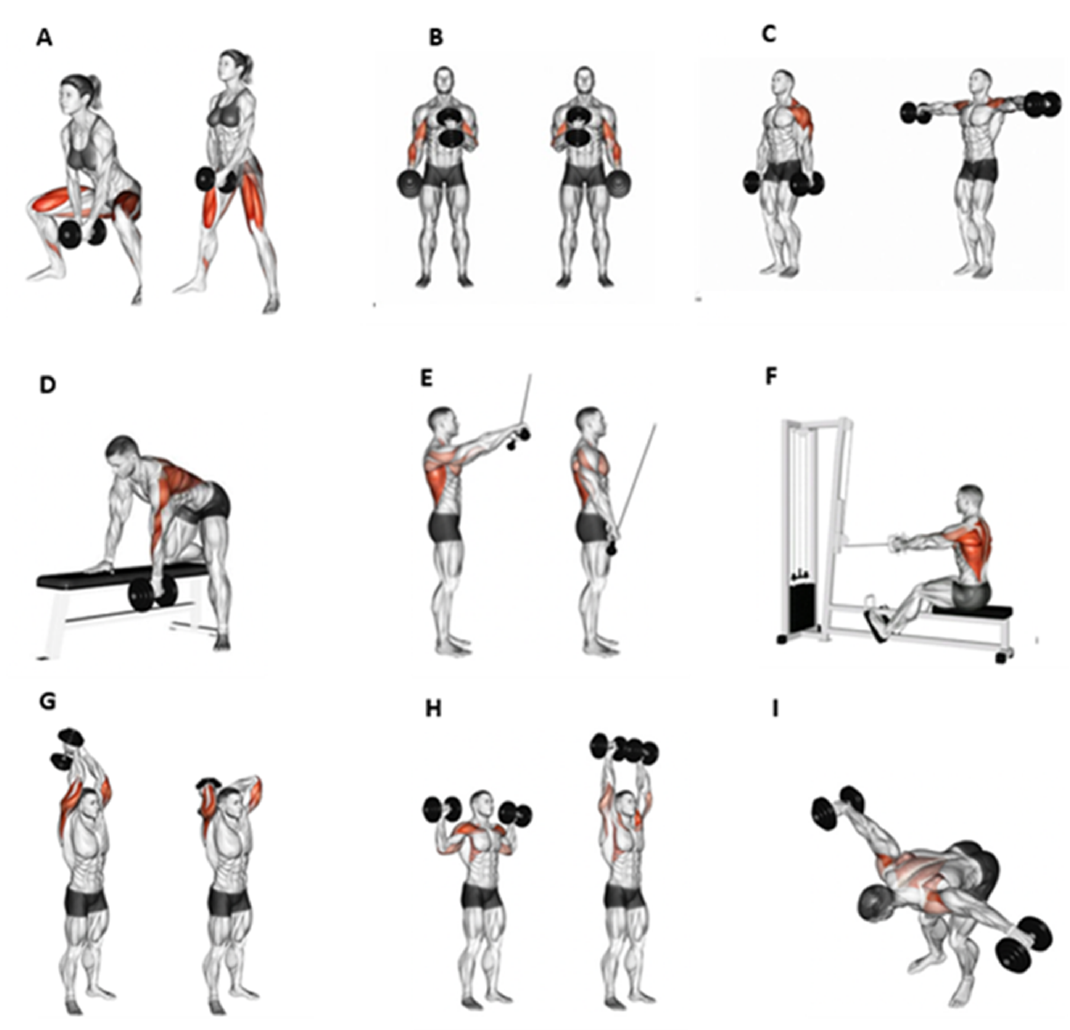
Figure 5. ( A ) Squat, ( B ) Hammer curl, ( C ) Side shoulder dumbbell raises, ( D ) Single arm dumbbell bench rows, ( E ) Straight arm pullover, ( F ) Seated cable back rows, ( G ) Standing triceps extension, ( H ) Shoulder press, ( I ) Dumbbell bent-over raise.